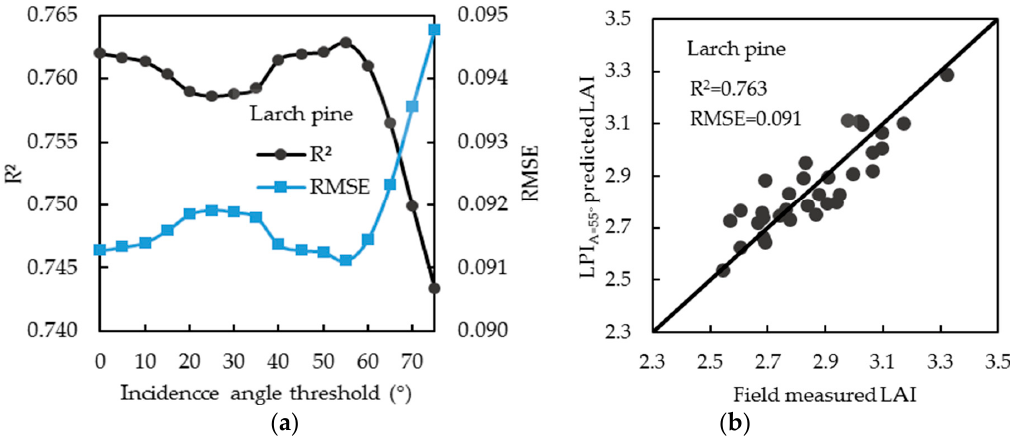
Figure 7. The LAI estimation results for Larch pine forests with incidence angle normalisation: ( a ) LAI estimation accuracy with different incidence angles; ( b ) The relationship between the field-measured LAI and LiDAR-predicted LAI when incidence angle threshold was set to 55° (i.e., LPI A=55° ). R 2 and RMSE are values from leave-one-out cross-validation.